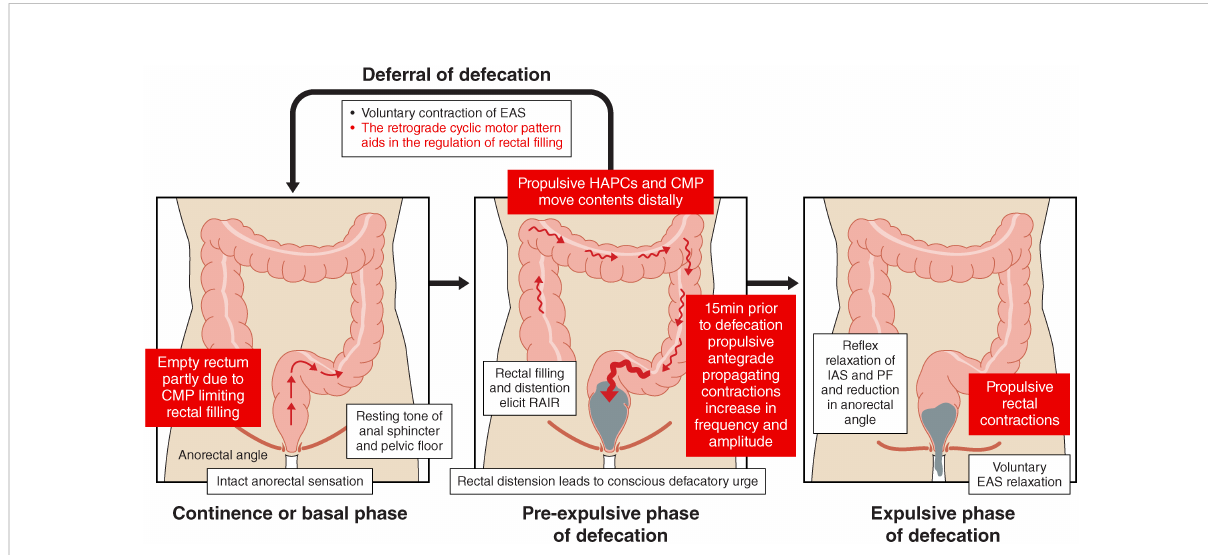
FIGURE 1 Physiological mechanisms of defecation with a focus on the role of colonic motility. The cyclic motor pattern (CMP) which characterises the rectosigmoid brake regulates rectal fi lling in the continence/basal phase. During the pre-expulsive phase of defecation, high amplitude propagating contractions (HAPCs) and the cyclic motor pattern facilitate antegrade transit. Important mechanisms of continence include ability of voluntary contraction of the external anal sphincter (EAS) and the rectosigmoid brake. The expulsive phase of defecation is facilitated by propulsive rectal contractions, voluntary EAS relaxation, and re fl ex relaxation of the internal anal sphincter (IAS) and pelvic fl oor (PF) muscles. Refer to refs (16, 44) for extended